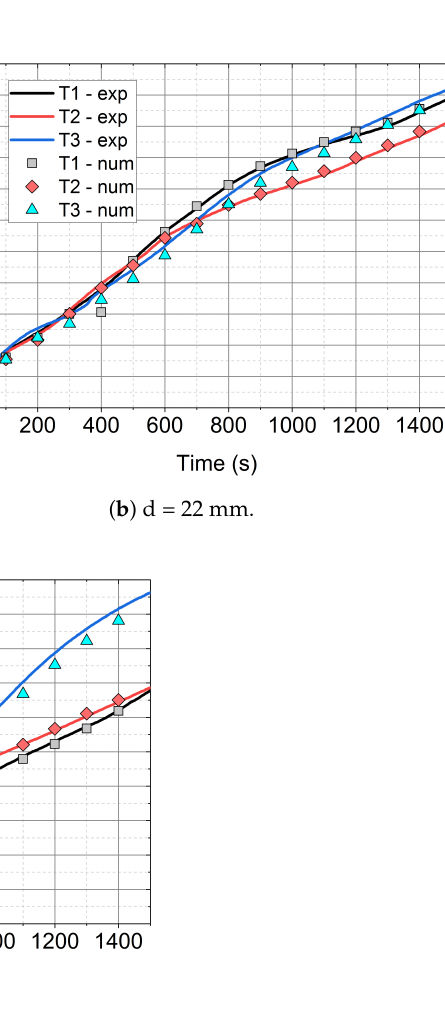
Figure 16. Comparison of the experimental and numerical results for the inlet velocity of 3.18 m/s and different cylinder di-